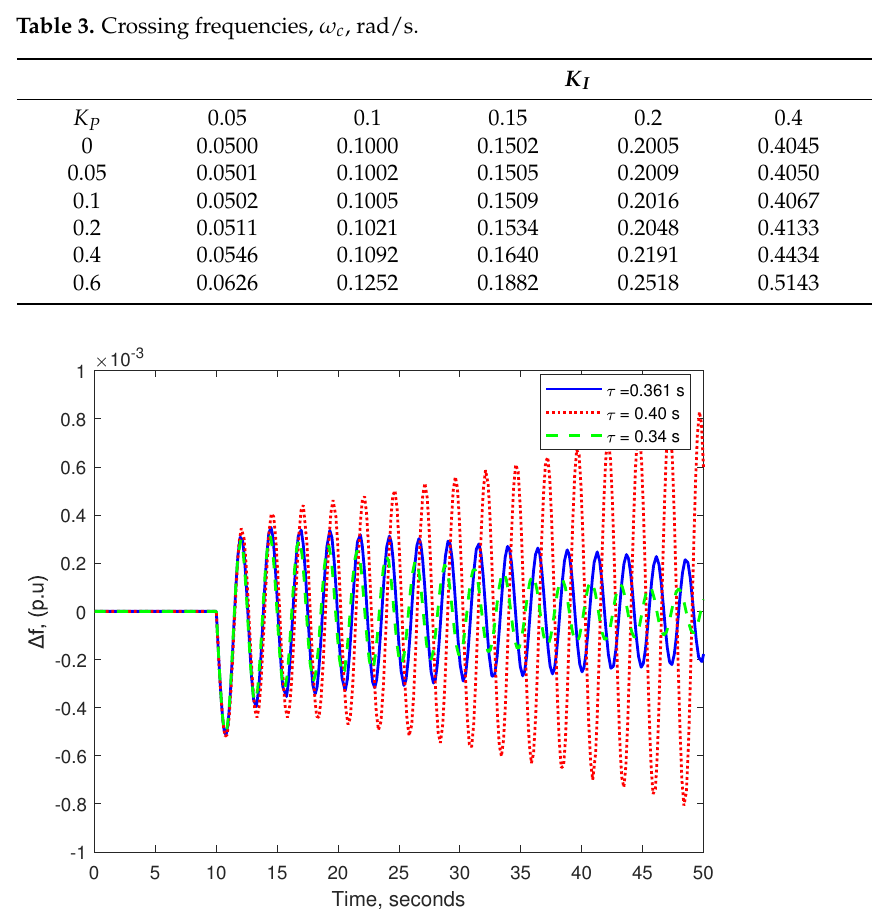
Figure 4. The frequency deviation with K P = 1 and K I =